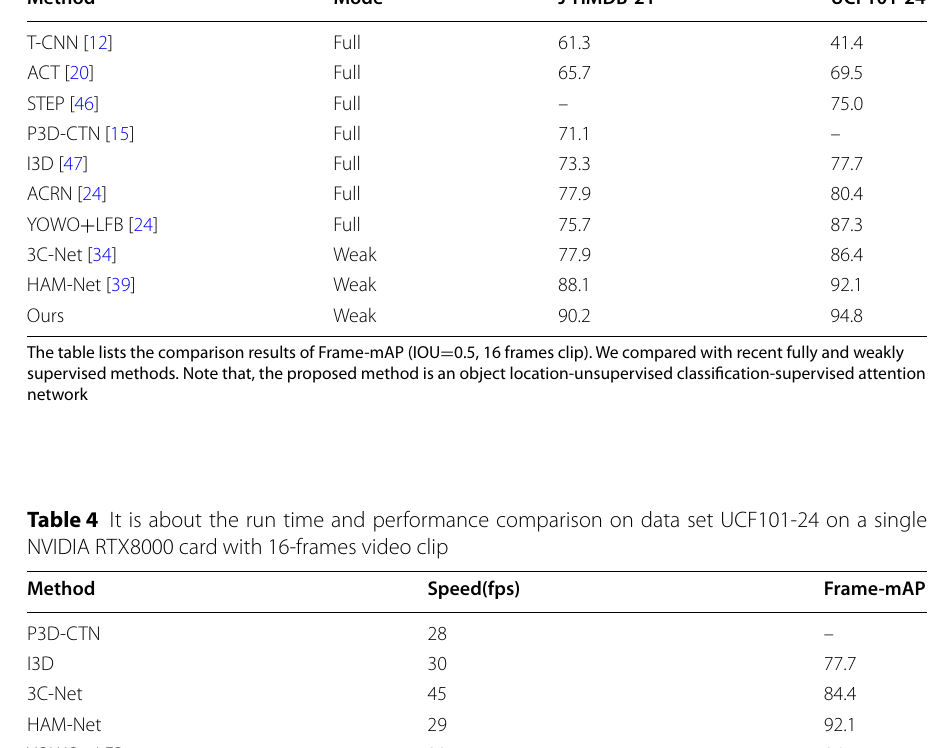
Table 3 Action classification experiment